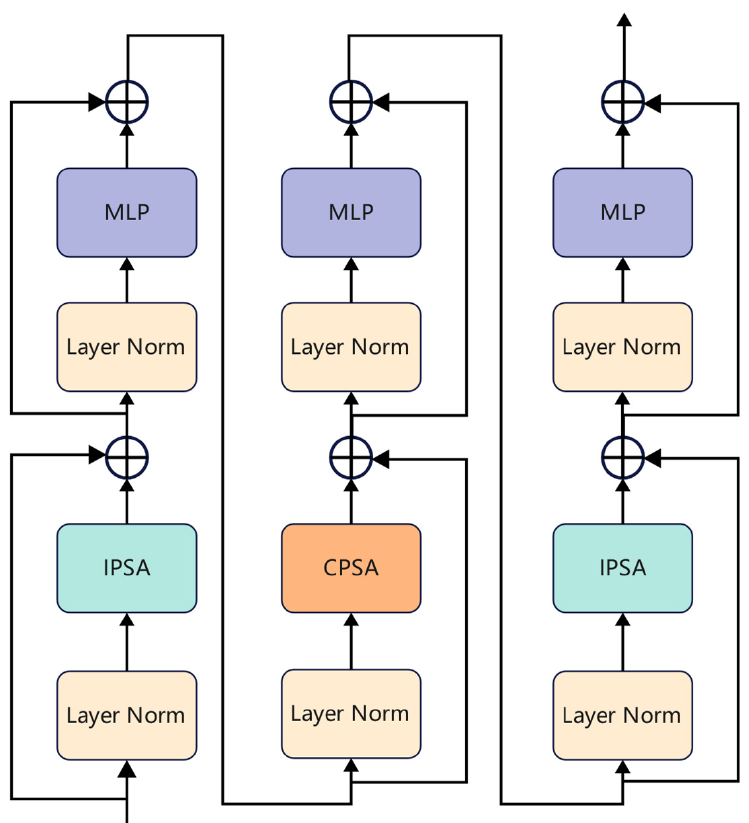
Figure 5. Cross-attention module stacking mode.